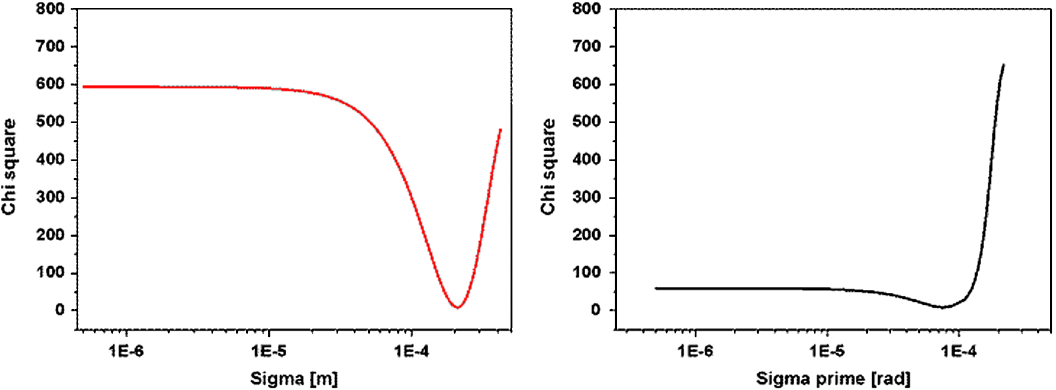
FIG. 8. The best fit parameter set is determined by using a chi-square minimization. Left: chi square vs beam size. Right: chi square vs angular